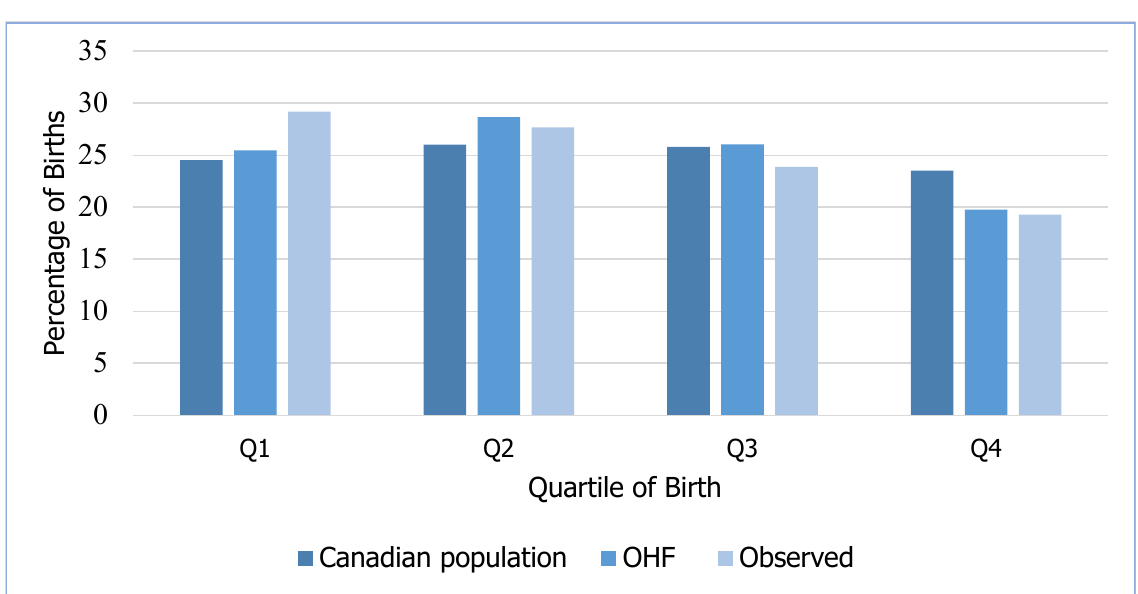
Figure 1. Comparison of Overall Birth Distributions by Quartile